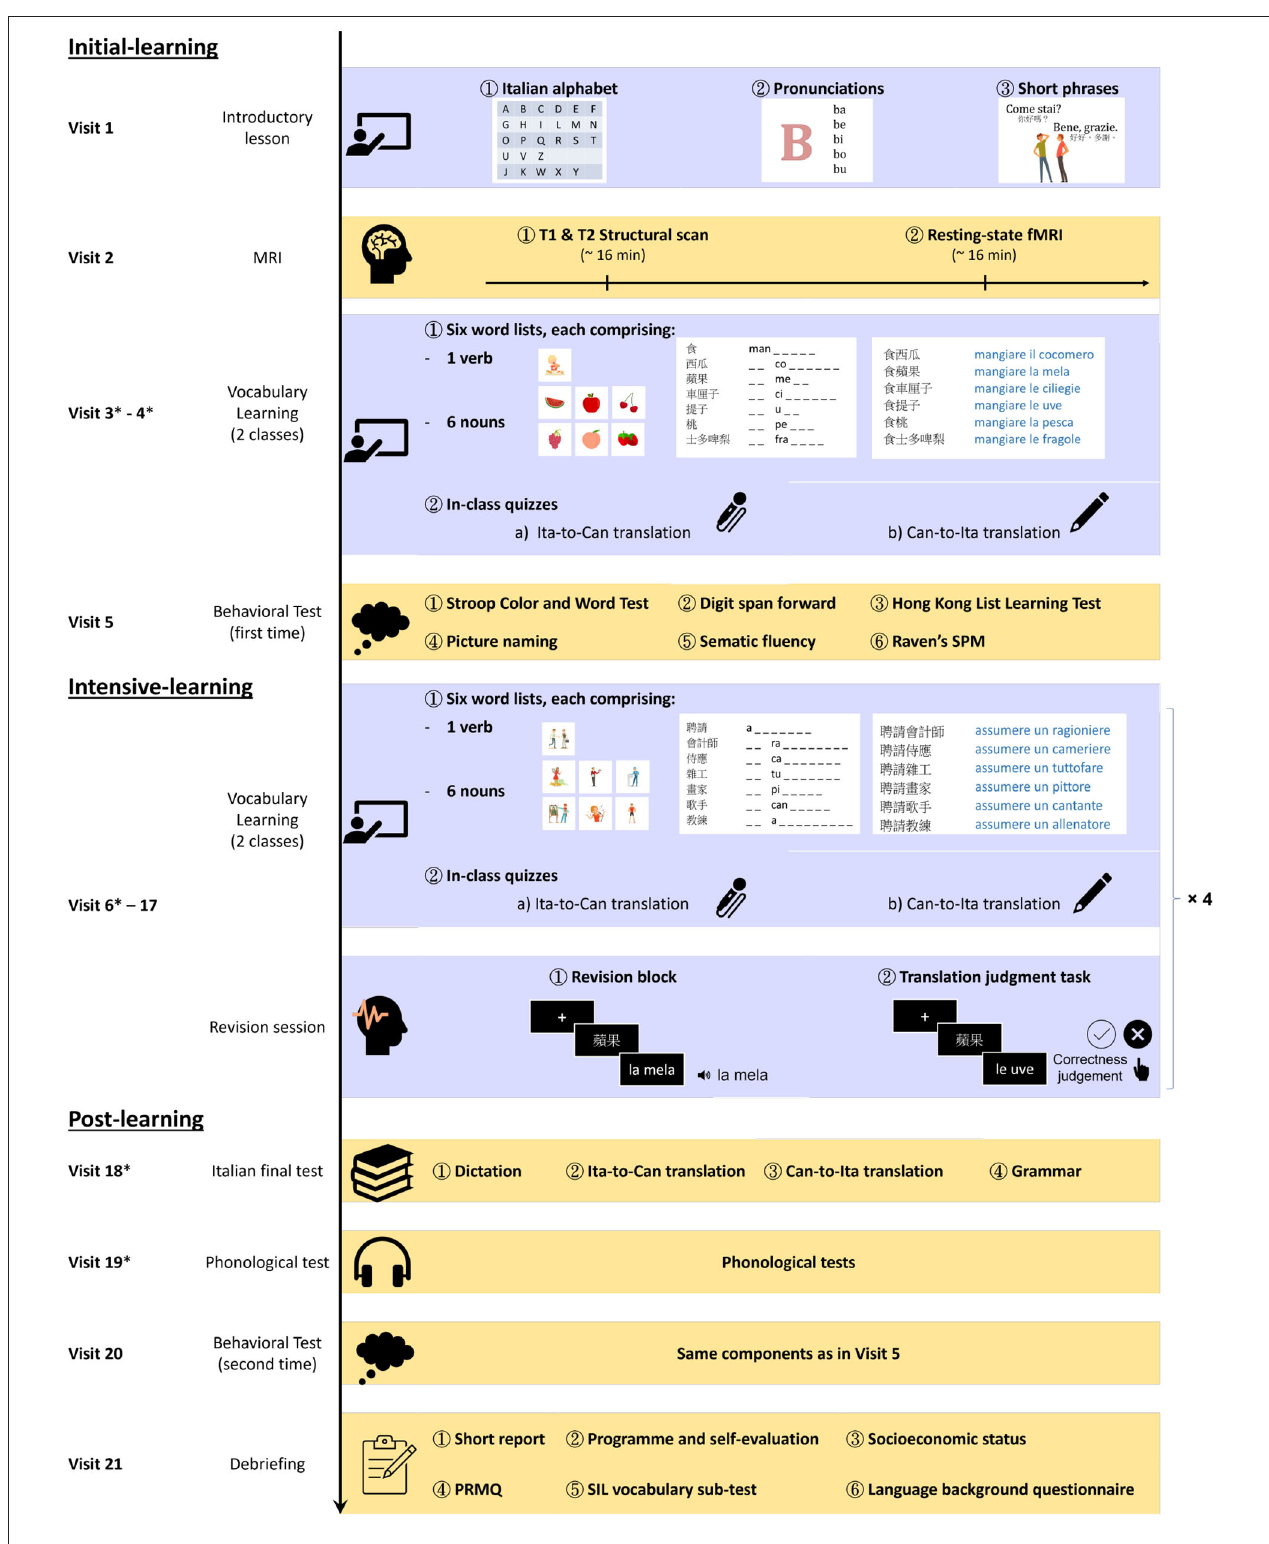
FIGURE 1 | Italian learning programme. The whole programme was divided into three phases—initial-learning (visits 1–5), intensive-learning (visits 6–17), and post-learning (visits 18–21). In the initial- and intensive-learning phases, six word lists were taught per vocabulary lesson, each comprising a verb and six nouns. After two vocabulary lessons, there was a revision session. Such a cycle of three sessions was repeated four times during the learning programme (hence × 4 in the figure). Asterisks (*) were used to indicate the visits during which phonological tests were administered (see main text).